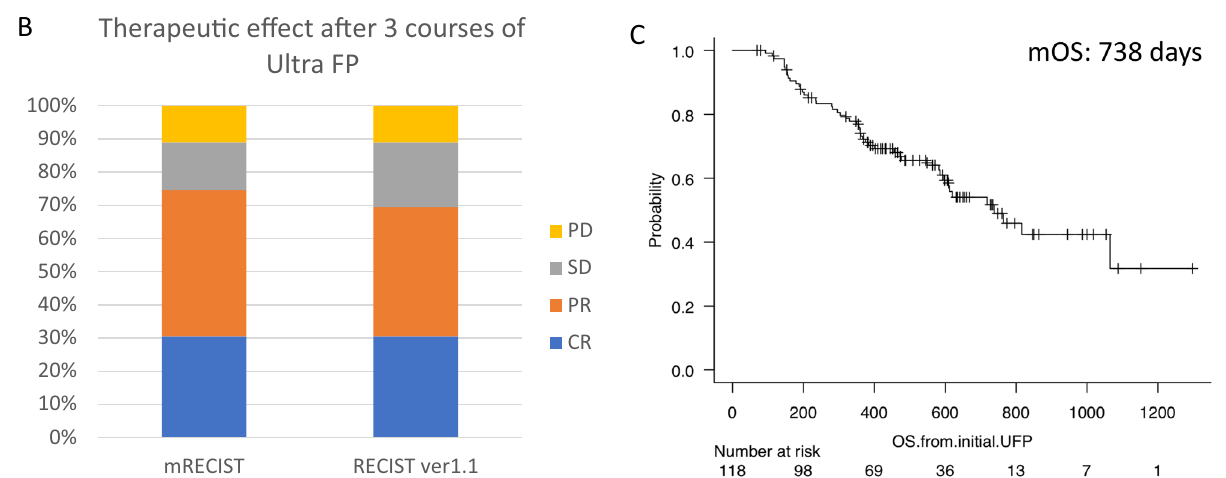
Figure 1. Flow chart of patients included in this study and survival and treatment response of Ultra FP therapy. Flow chart of patients included in this study is shown ( A ). Treatment response of all included patients treated by Ultra-FP therapy (modified Response Evaluation Criteria in Solid Tumors (mRECIST) and RECIST ver1.1) is shown ( B ). The survival curve of included patients analyzed by Kaplan–Meier method is shown ( C ). mOS of all included patients (118 patients) was 738 days (24 months) ( C